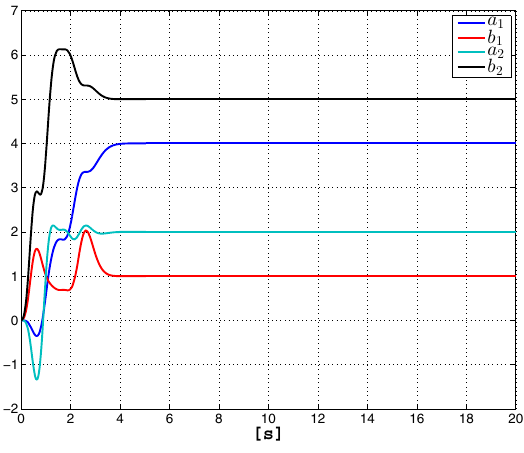
Figure 2. Example 1. Estimated